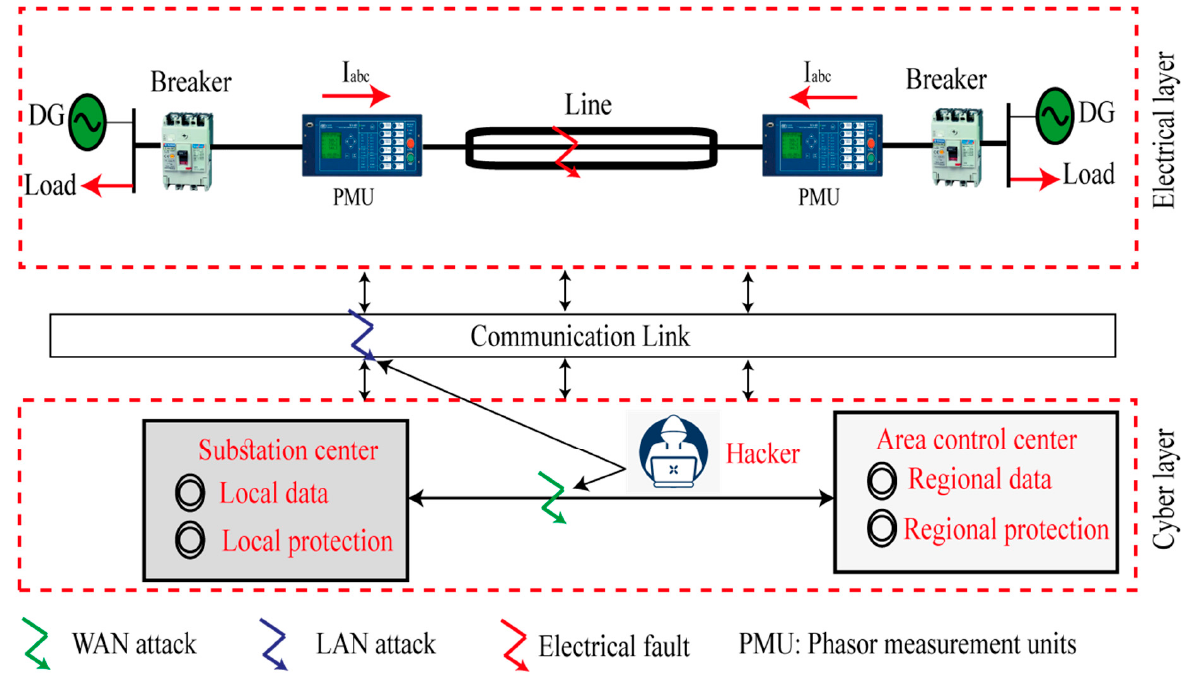
Figure 1. Electrical and cyber-attacks faults in the power grid.